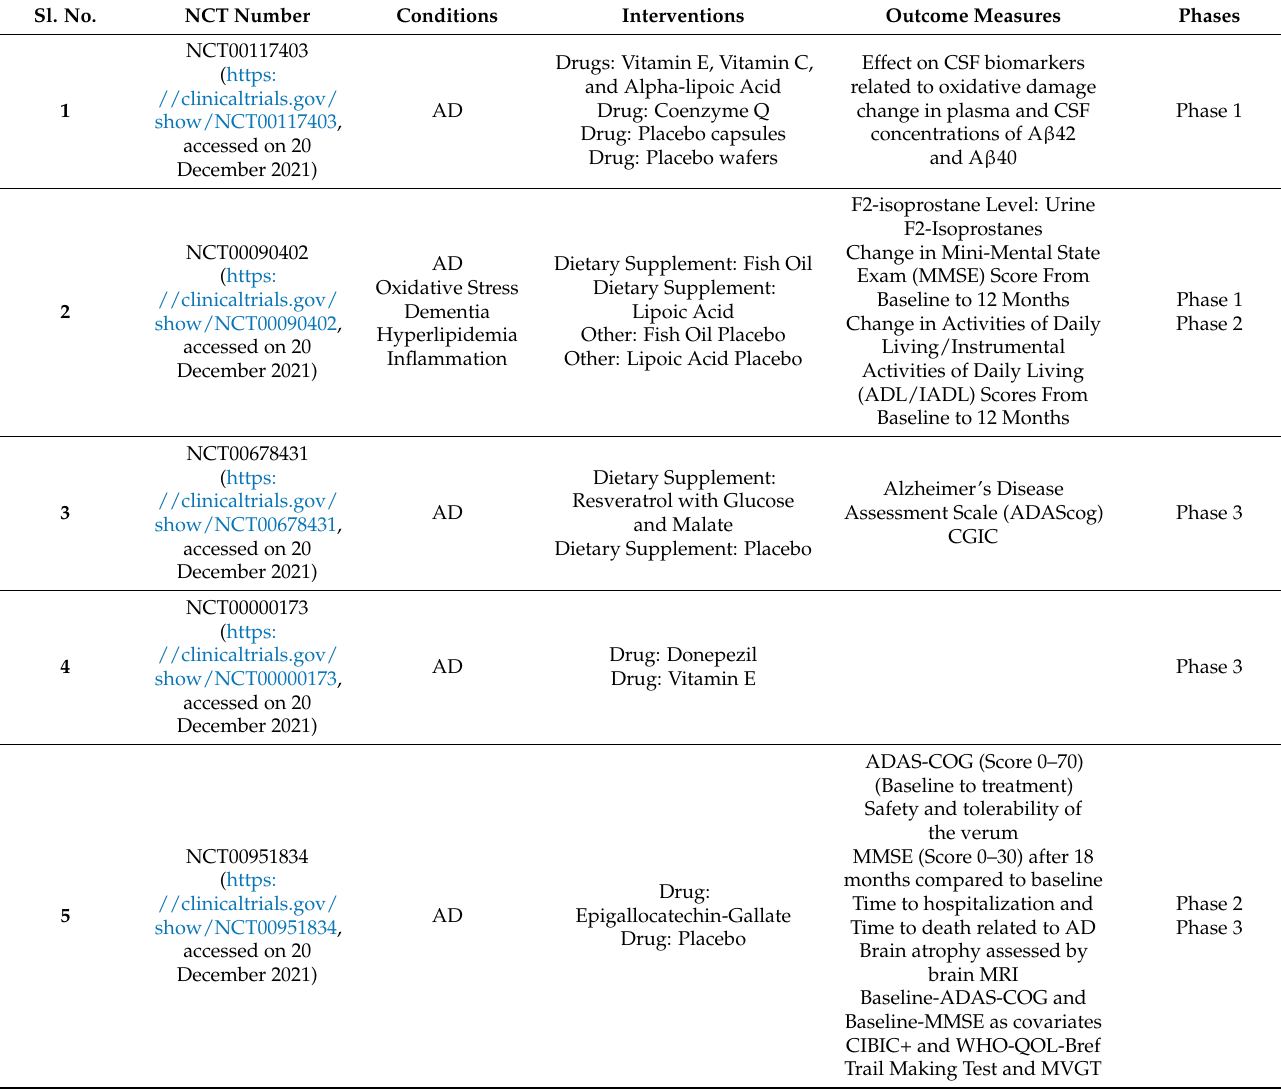
Table 3. Completed clinical trials conducted for antioxidants relevant to AD (“Completed” status here means the study has ended, and participants are no longer being examined or treated (that is, the last participant’s last visit has